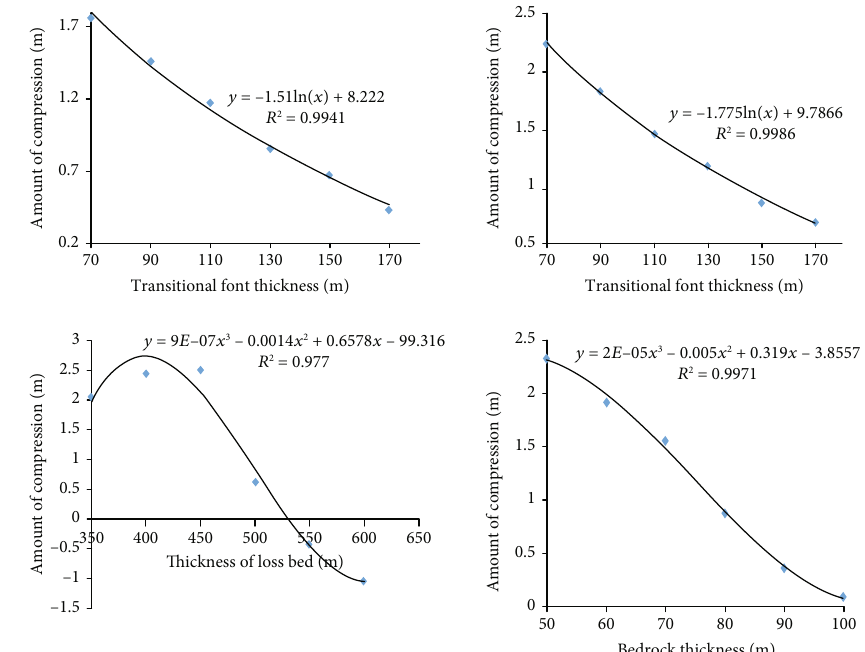
Figure 17: Compression curve and fi tting curve of various factors.